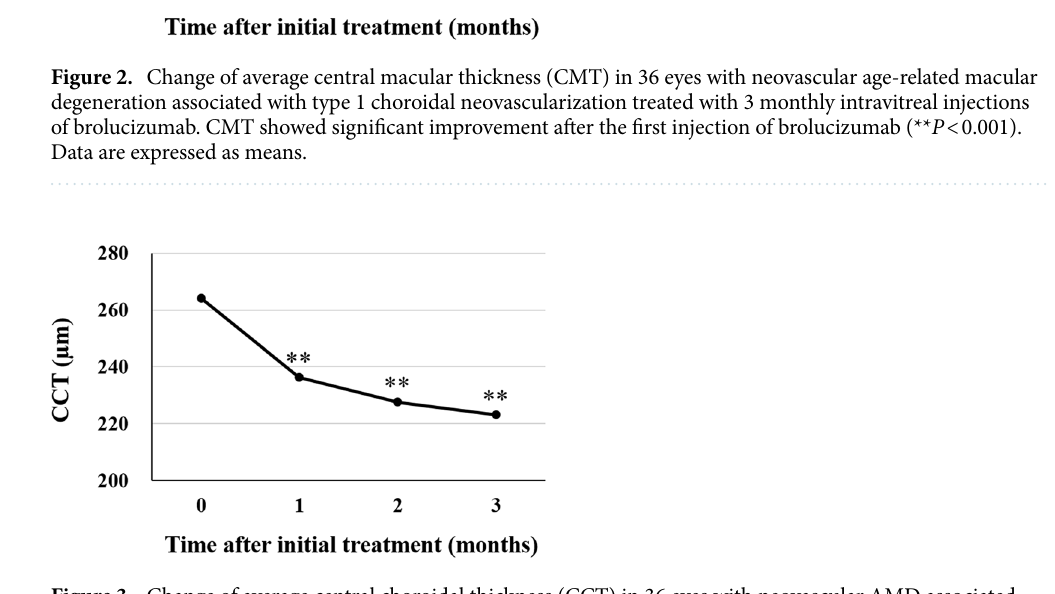
Figure 3. Change of average central choroidal thickness (CCT) in 36 eyes with neovascular AMD associated with type 1 choroidal neovascularization treated with 3 monthly intravitreal injections of brolucizumab. CCT showed significant improvement after the first injection of brolucizumab (** P < 0.001). Data are expressed as